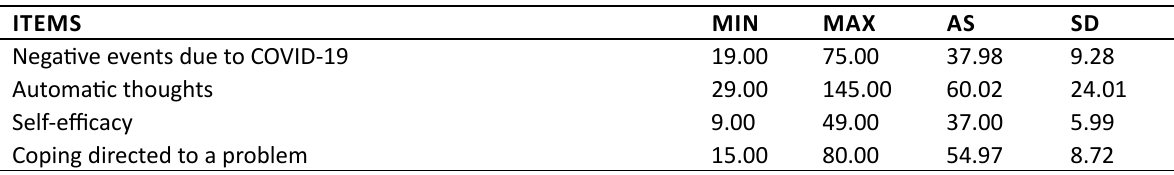
Table 1b. Descriptive parameters on the subscales of measuring instruments Items Coping directed to a problem Coping focused on emotions Coping by avoidance